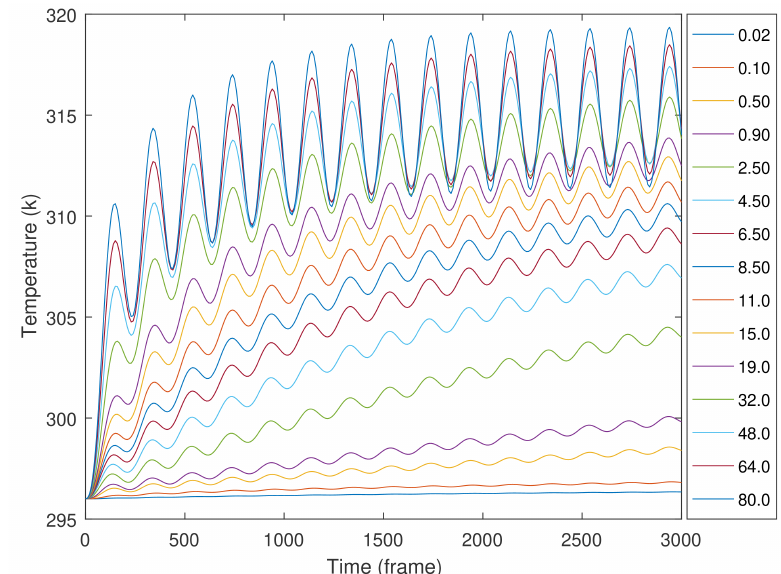
Figure 7. Temperature evolution at the center of slot 1 for cycle periods of 0.02, 0.10 up to 80